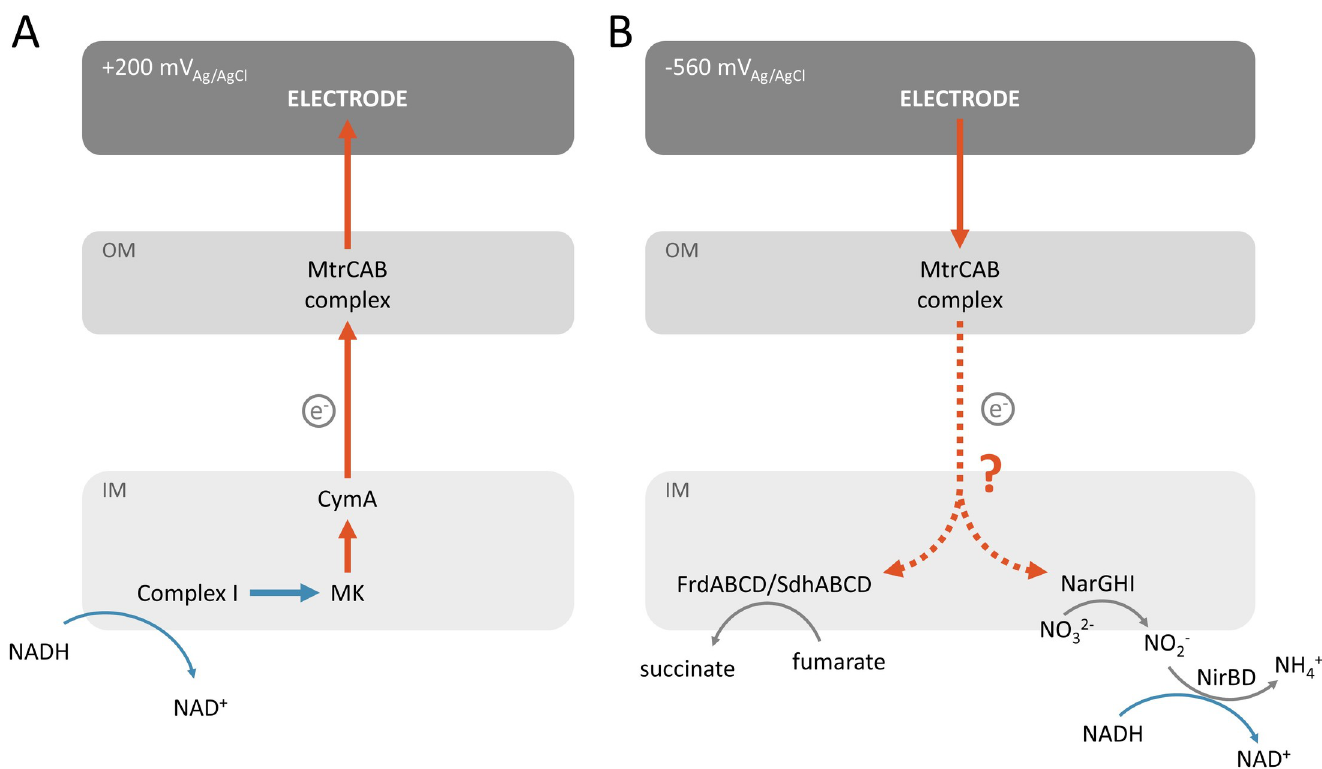
Fig 6. Model for how heterologously expressed MtrCAB couples intracellular oxidations (left) and reductions (blue arrows) to current production and consumption, respectively, in E . coli . (A) Oxidation of NADH by Complex I transfers electrons to MK. Electrons flow from MK via CymA to the MtrCAB complex. (B) MtrCAB transfer electrons via an unknown process to FrdABCD/SdhABCD and the NarGHI enzymes, which in turn reduce fumarate and nitrate to succinate and nitrite, respectively. Further reduction for the nitrite to ammonia is mediated through